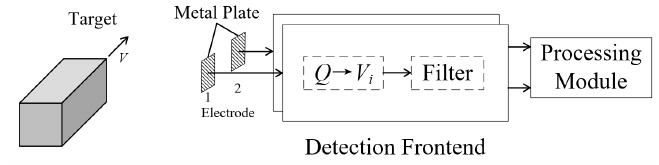
Figure 9. Schematic diagram of the velocity measurement model.